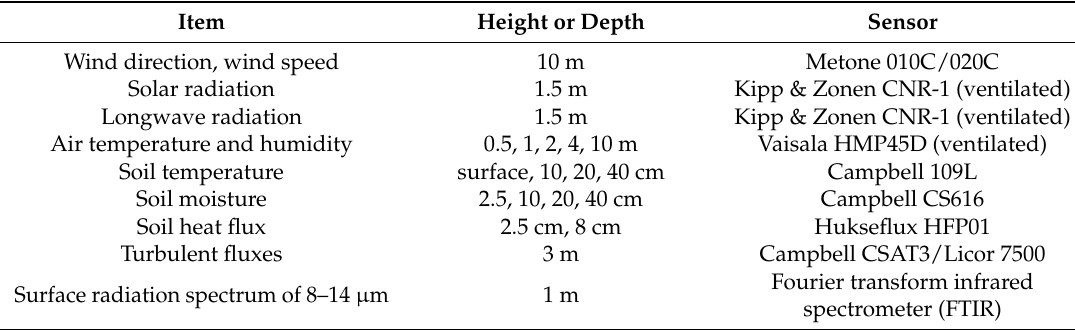
Table 1. Measurement levels and instruments employed for acquiring near-surface meteorological variables and turbulent fluxes at Xiaotang